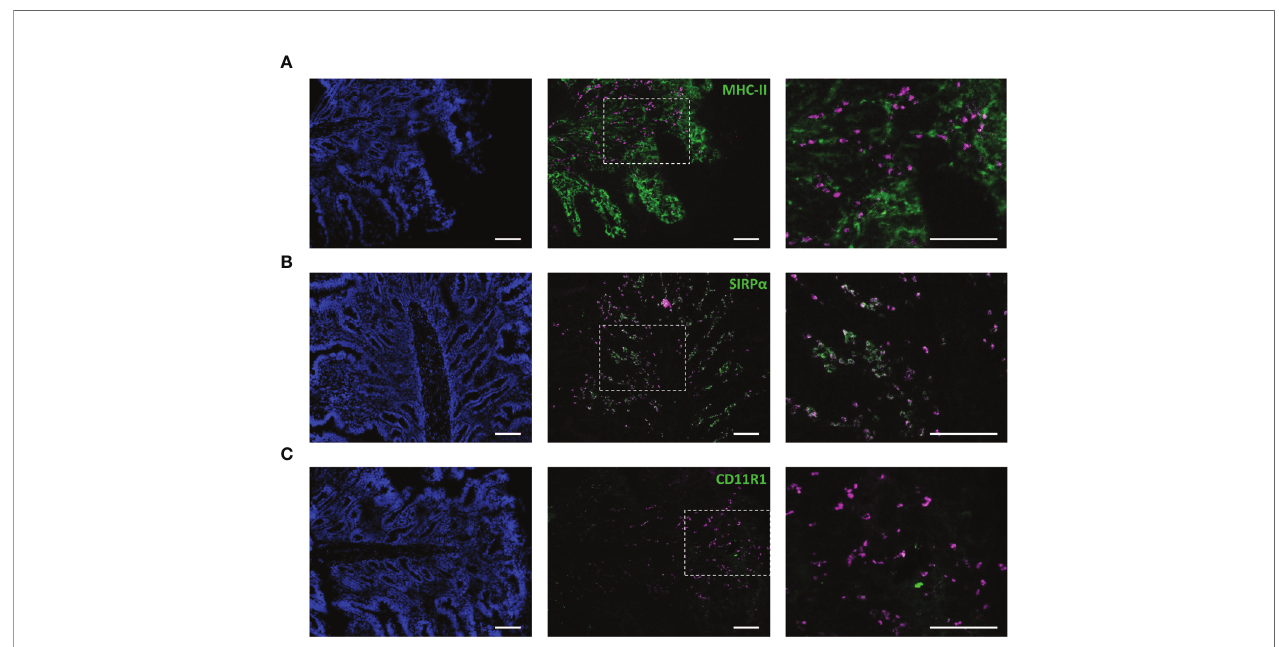
FIGURE 4 | Antibody-mediated targeting to APN results in uptake by antigen presenting cells upon epithelial transcytosis. Cryosections from ligated gut loops injected with IMM013-DL755 (magenta) and incubated for 5 h. Left images showing cell nuclei (blue). Right images represent the squared boxes of the merged images. Cryosections were immunostained for (A) MHC-II (Green) (B) SIRP a (Green) and (C) CD11R1 (Green). Double positive cells in white. Scale bar: 100 µm. Images are representative of three